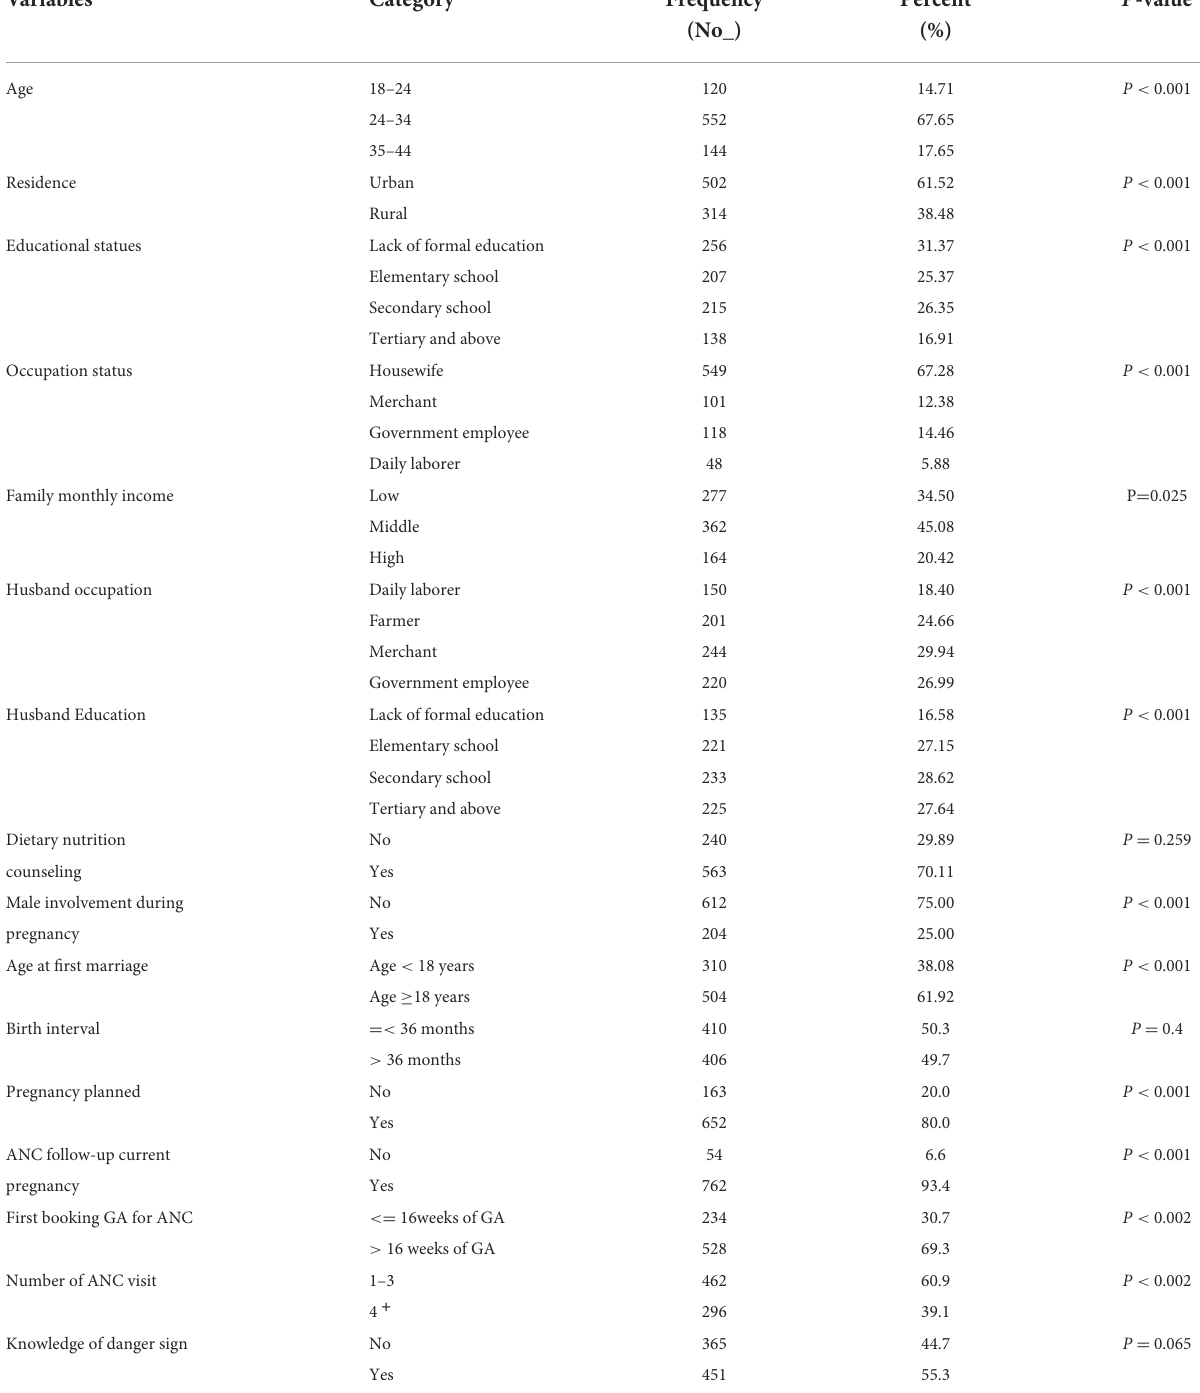
TABLE 1 Selected baseline sociodemographic and reproductive health characteristics of the study groups in public hospitals in the Sidama Reginal State of Ethiopia, 2021. Variables Category